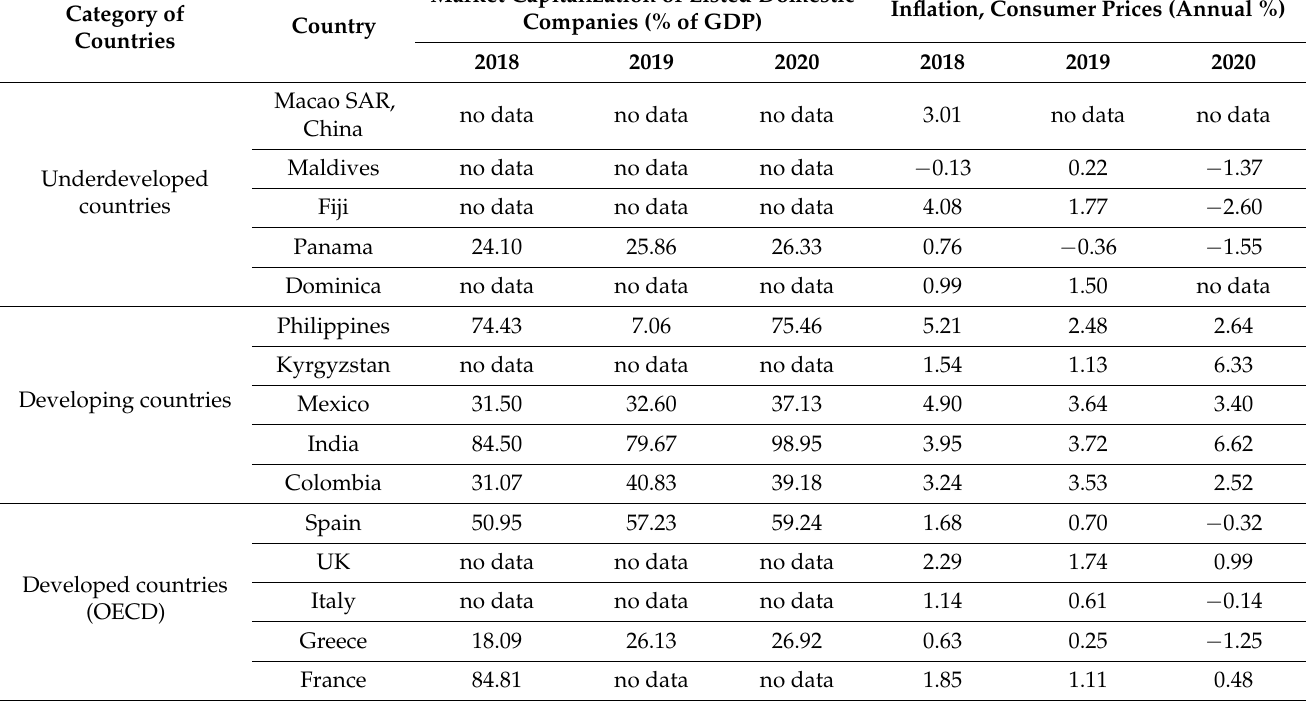
Table 2. Statistics characterizing monetary risks in the highlighted categories of countries in 2018–